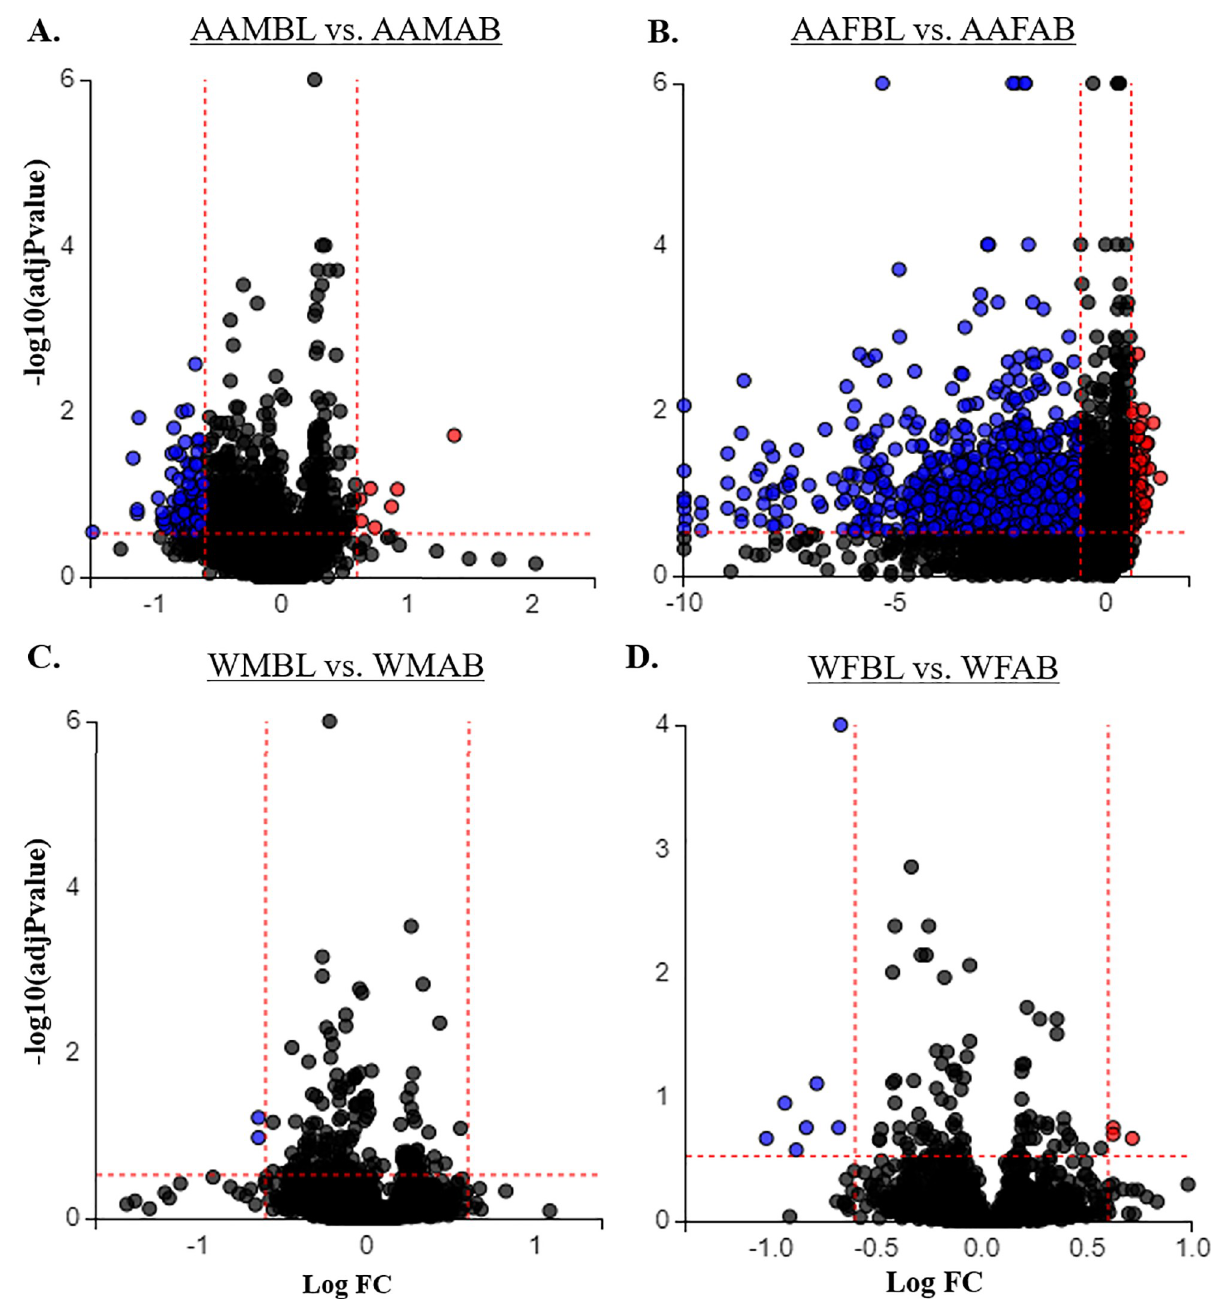
Fig 1. Gene expression changes associated with poverty in the HANDLS cohort. Significantly and differentially-expressed genes were identified in Baltimore City residents living below (BL) vs above (AB) poverty via microarray. Volcano plots generated in iPathway Guide show significantly (| LogFC| > 0.6, FDR AdjPvalue < 0.3) up-regulated (red) or down-regulated (blue) genes in individuals living in poverty who were (A) African American males (AAM), (B) African American females (AAF), (C) white males (WM), or (D) white females (WF) (N = 6/7 per group; see S1 Table for completely